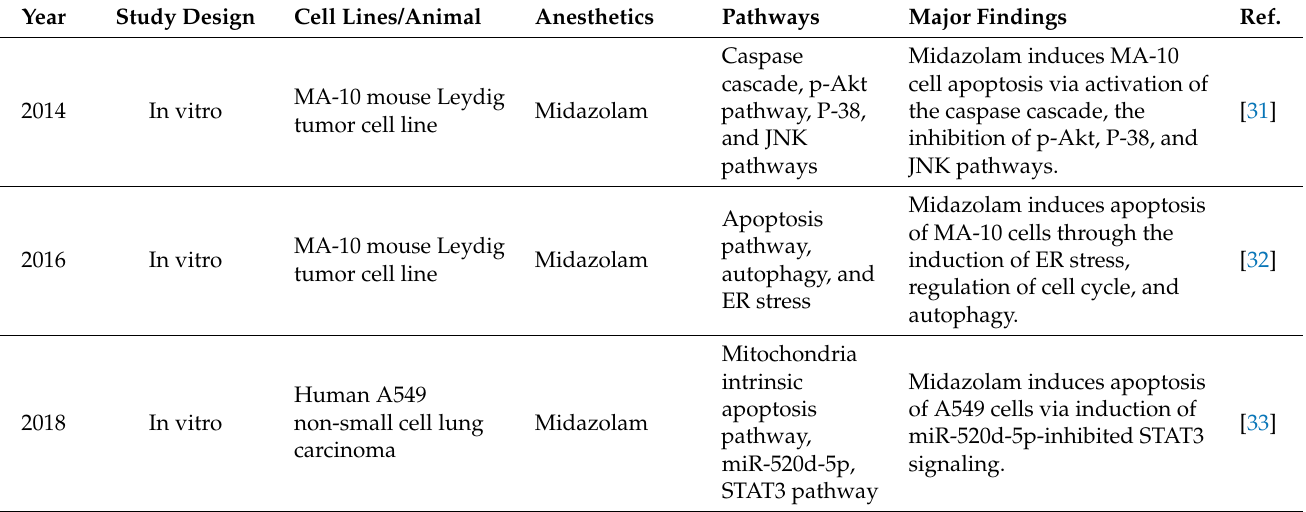
Table 3. Summary of the anti-cancer effects of the